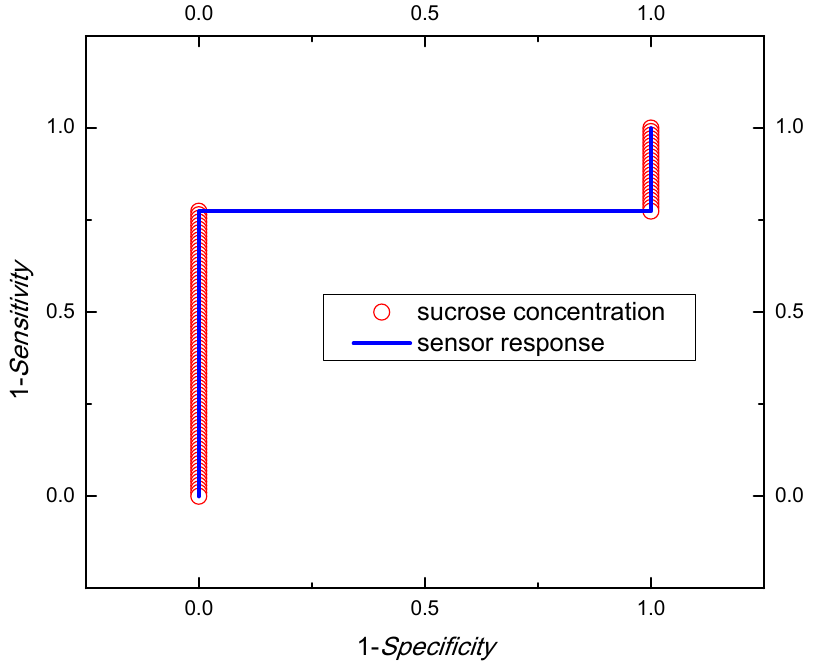
Figure 9. Sensitivity and specificity test for sensor response.